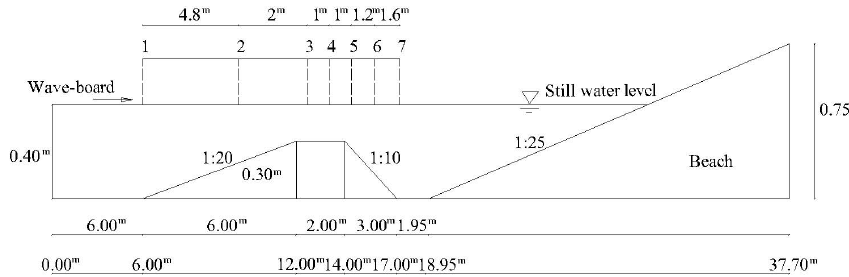
Fig. 6. Schematic diagram of Beji and Battjies’ (1994) experimental